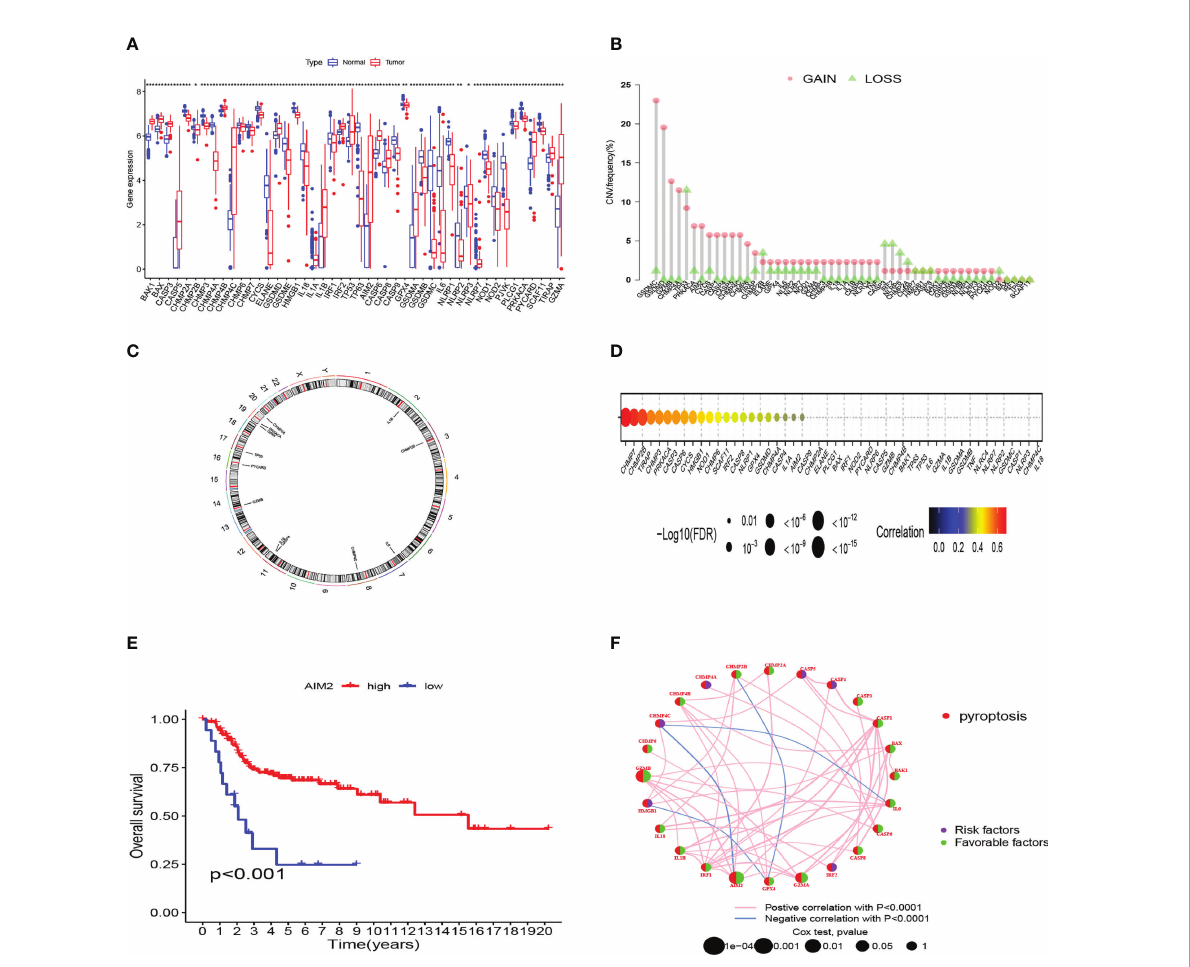
FIGURE 1 Genetic and transcriptional characteristics of PRGs in OS. (A) The differential expression of 46 PRGs between normal and OS tissues. (***:p value <0.001, **:p value <0.01, *:p value <0.05) (B) CNV frequency of PRGs in the TARGET cohort. (C) Locations of CNV alterations of PRGs on 23 chromosomes by the TARGET cohort. (D) The correlation analysis between CNV of PRGs and RNA sequence expression of PRGs in the TARGET cohort. (E) The K-M curves of AIM2 gene in OS. (F) Prognosis value and correlations between PRGs in OS. The line linking the PRGs is their correlation. PRGs, pyroptosis- related genes; OS, osteosarcoma; CNV, copy number